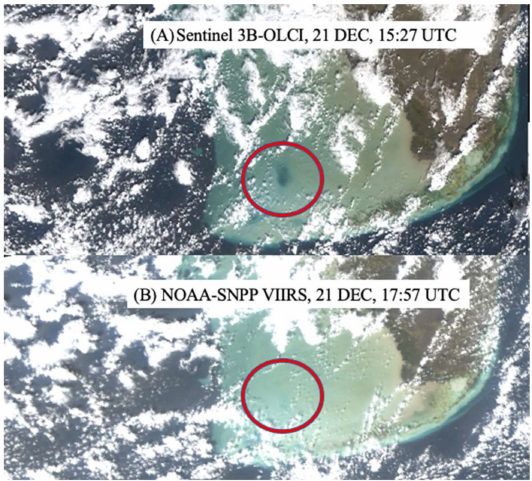
Figure 10. ( A ) OLCI TC on 21 Dec 1527 UTC and ( B ) VIIRS on 21 Dec 1757 UTC. The color-enhanced ABI image sequence (GOES-East, [23]) clearly shows the temporal progress of the presumed vertical mixing (Supplementary Materials Video S1; Figure 11). The darker ocean area was discernable from 1400–1600 UTC (Figure 11A,B) and became less distinct through 1800 UTC (Figure 11C,D). The rapid hourly change in the surface water color properties over a large ocean area (~147 km 2 ) suggests vertical mixing was the dominant physical process, as opposed to horizontal advection and diffusion. This change is consistent with the hypothesis that the discoloration is due primarily to the vertical resuspension of particulates.